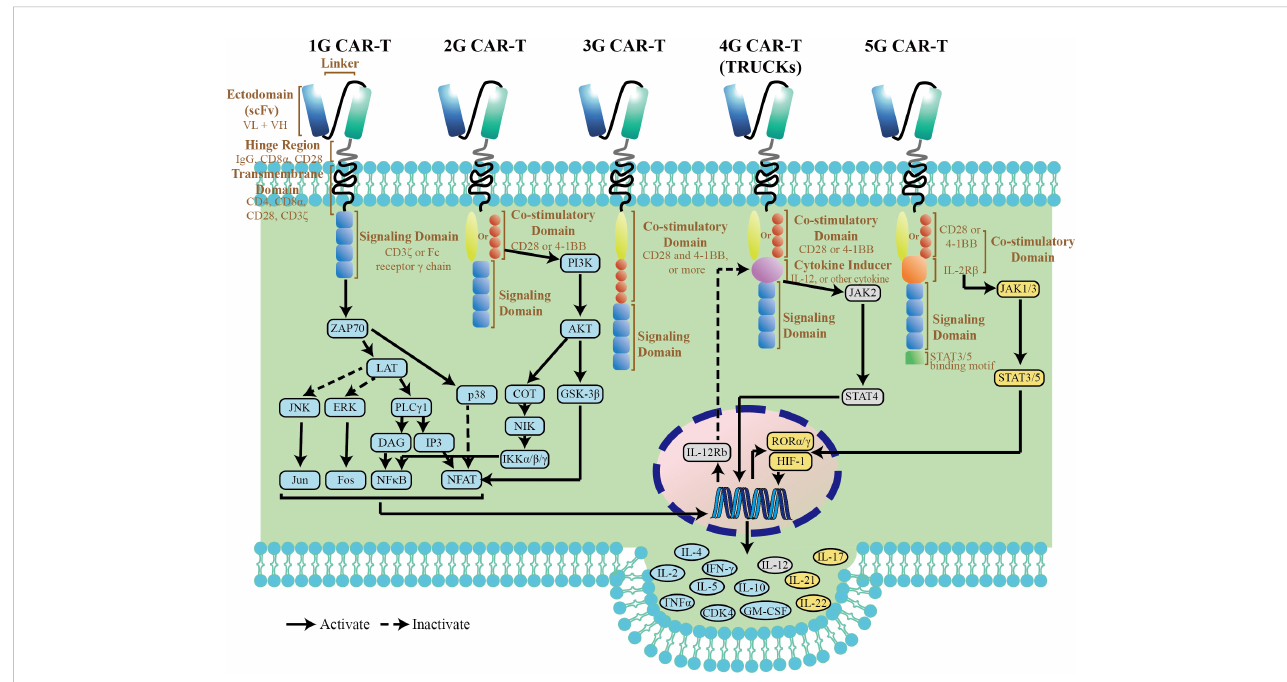
FIGURE 1 Structure diagram and simple pathway map of CAR-T cells. The pathway map is referenced from KEGG